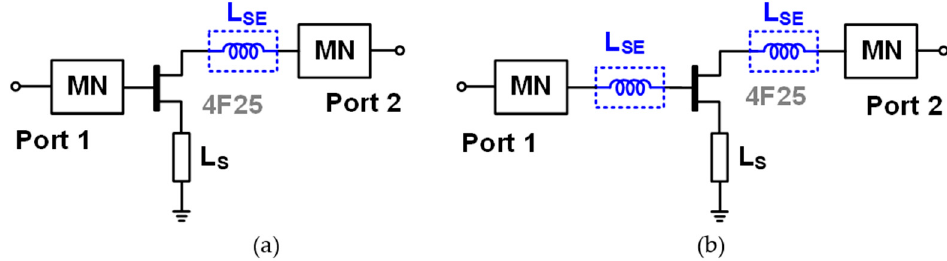
Figure 5. Single-stage common-source GaN HEMT-based amplifier configuration (4F25) ( a ) with a series inductor at the drain node and ( b ) with series inductors at both gate and drain nodes.